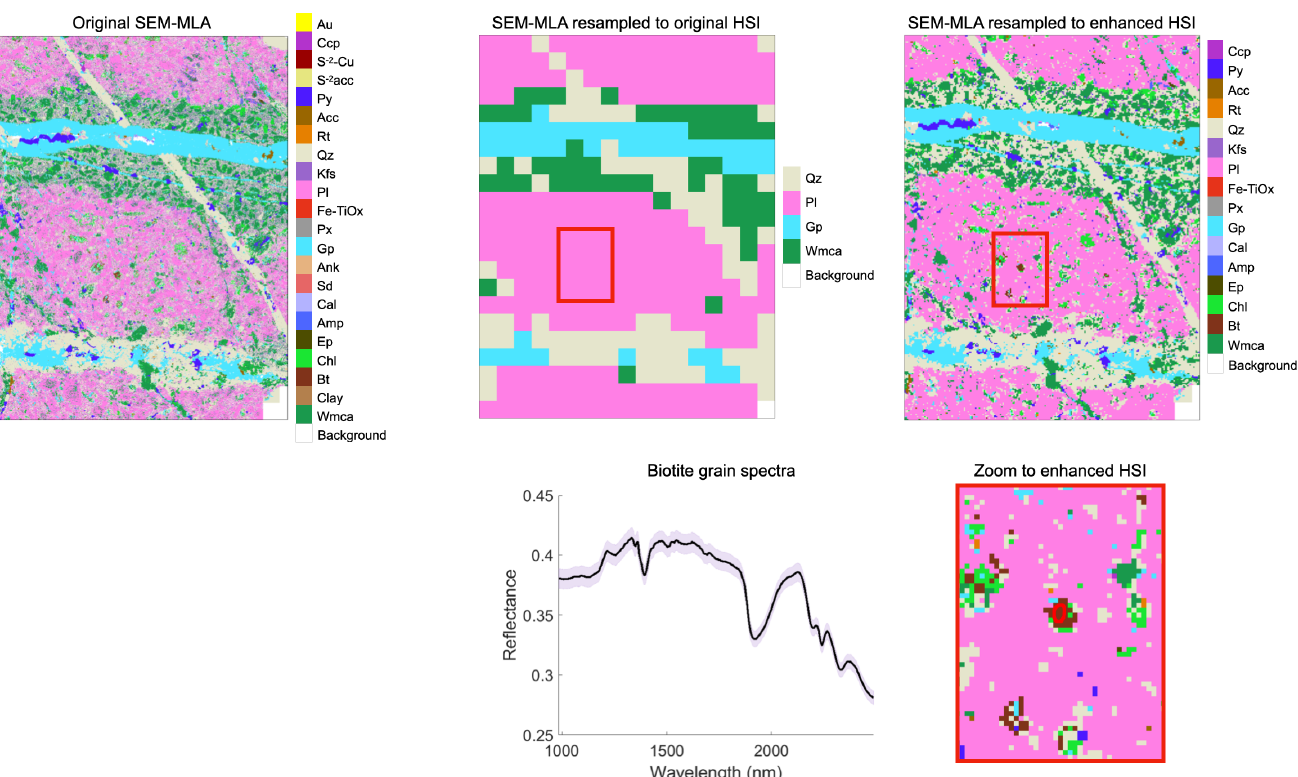
Figure 7. SEM-MLA performed over a small section of Sample 3 (top section in Sample 3 in Figure 2) at the original resolution (3 µ m GSD), resampled to the original resolution of the hyperspectral (HSI) data (1.5 mm GSD), and resampled to the enhanced HSI resolution (0.1 mm GSD). Below is a zoom of the red squared over the enhanced HSI map and the spectra of the biotite (Bt) grain pointed with the red sphere. (Wmca—white mica, Bt—biotite, Chl—chlorite,